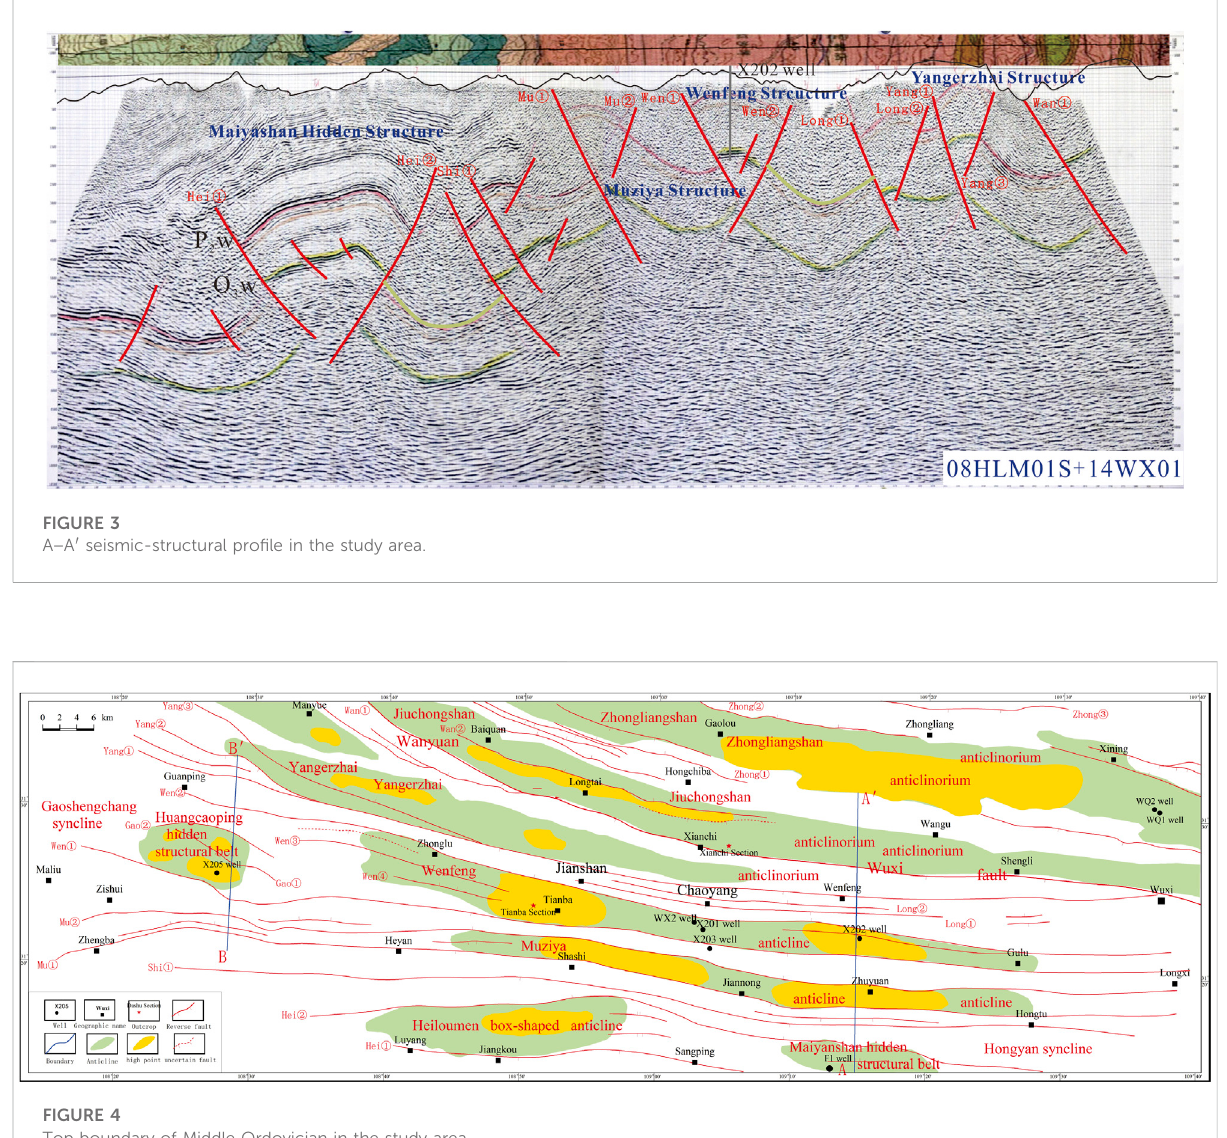
FIGURE 4 Top boundary of Middle Ordovician in the study